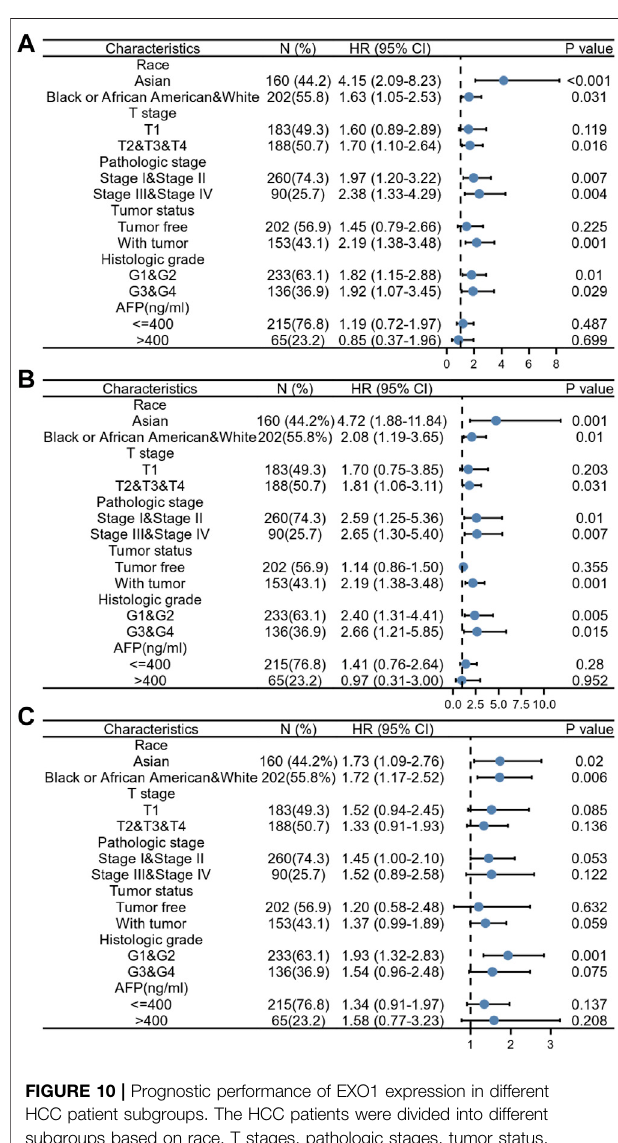
Frontiers in Molecular Biosciences |